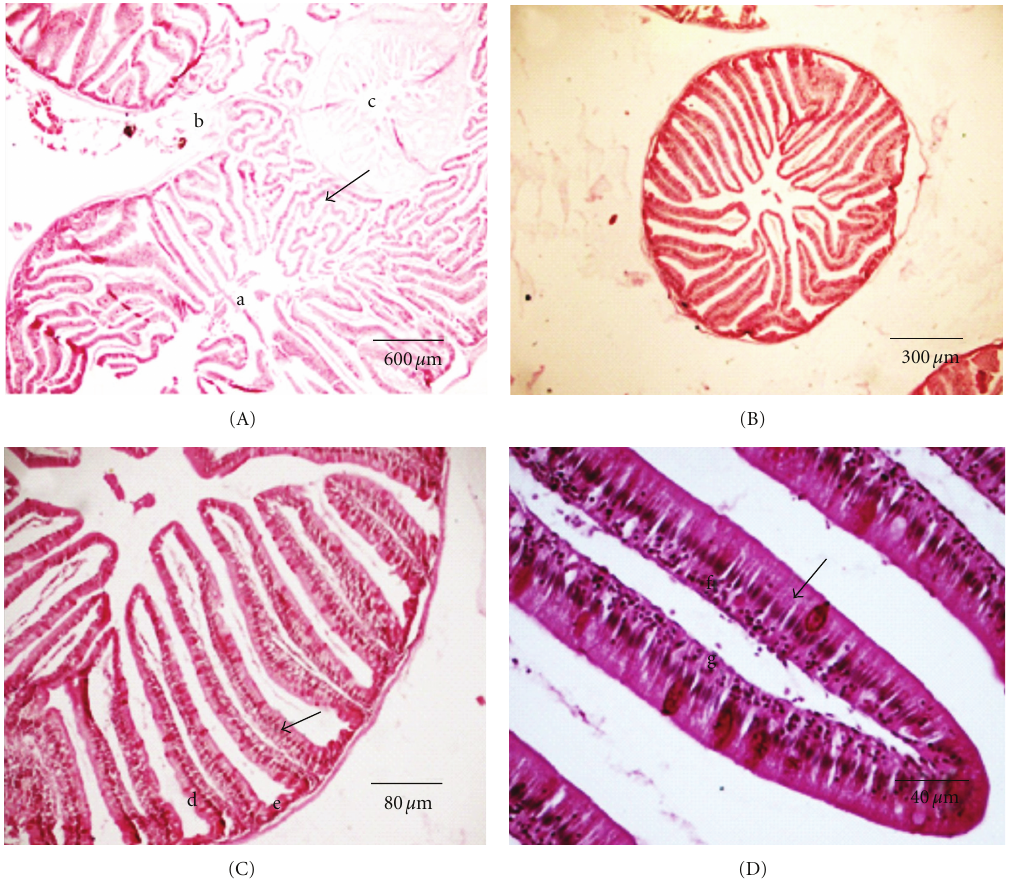
Figure 7: Pyloric caeca of S. fuscus . (A) Insertion of caeca (a) in bolsa serosa (b) common to pyloric stomach (c), conjunctive of serosa originating the lamina propria of caeca (arrow); (B) pyloric caeca with mucosa containing numerous folds; (C) caeca with simple cylindrical epithelium showing goblet and absorptive cells (arrow) and lamina propria (d) supported on fine muscle layer (e); (D) cecal fold with epithe- lium (f) nonglandular lamina propria (g) and goblet cells